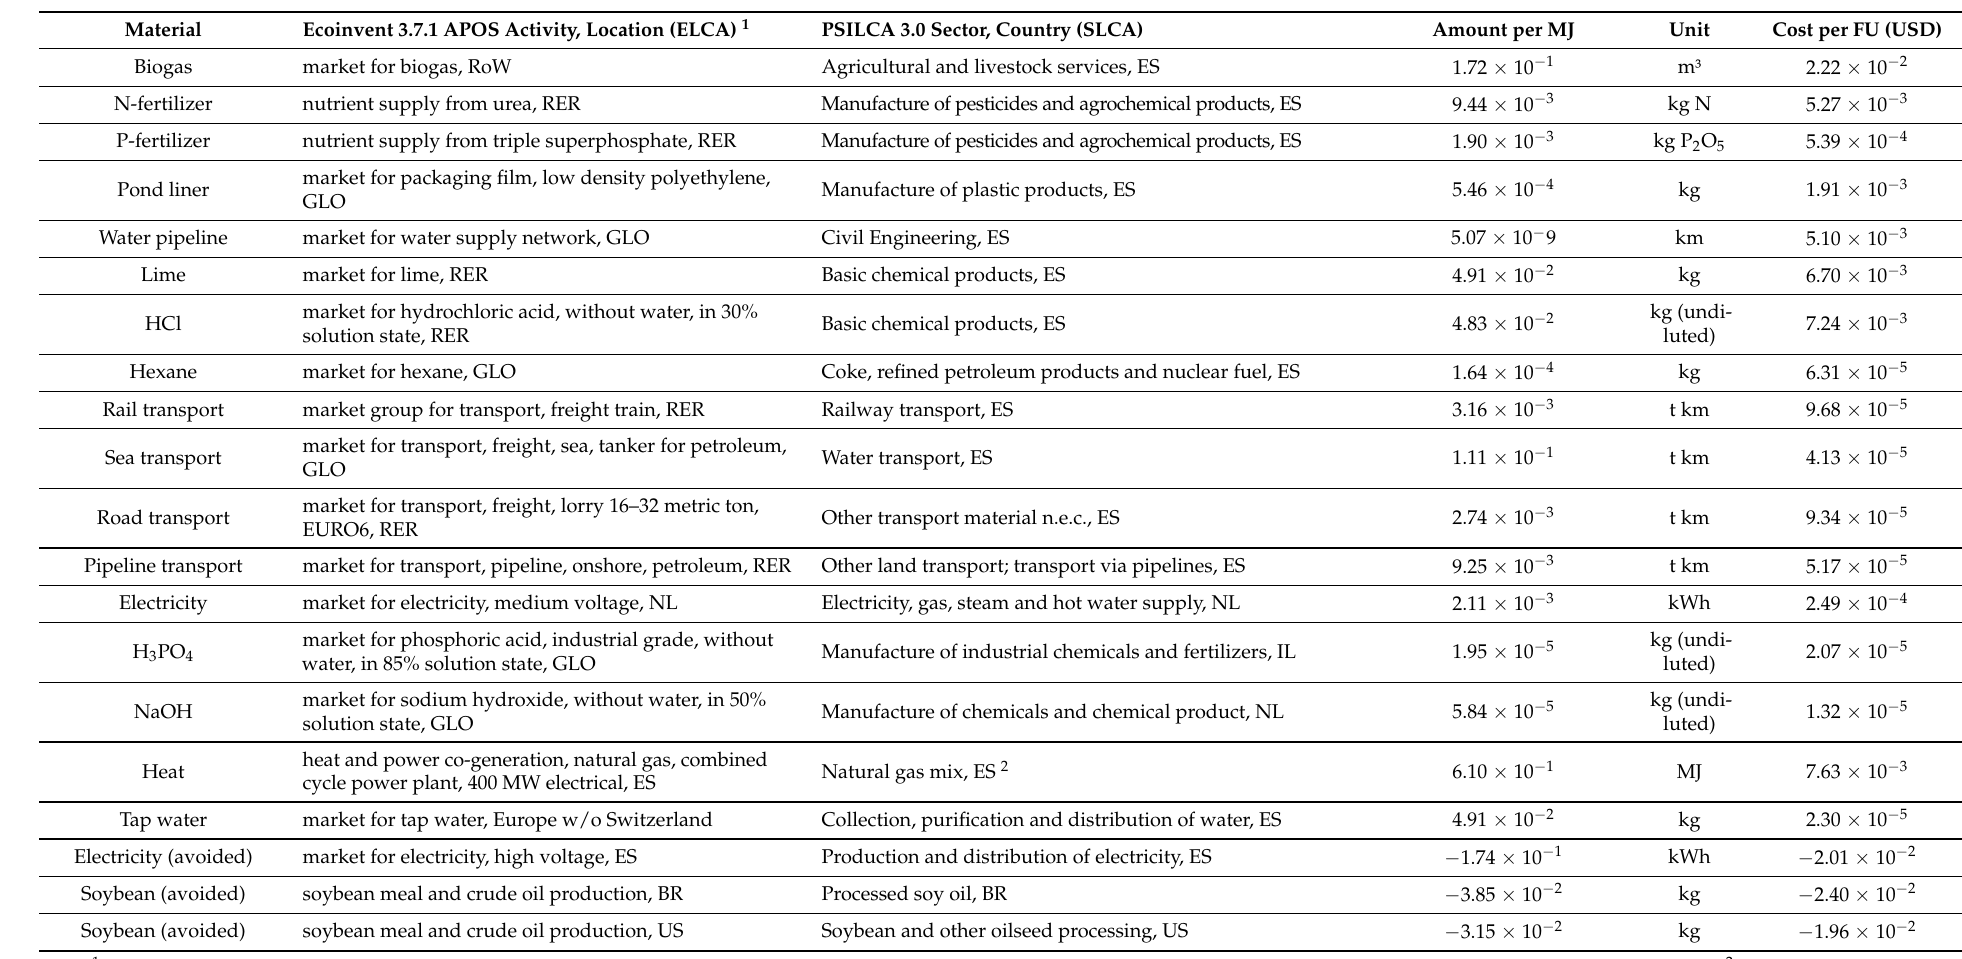
Table 2. Inventory of the AF + fodder